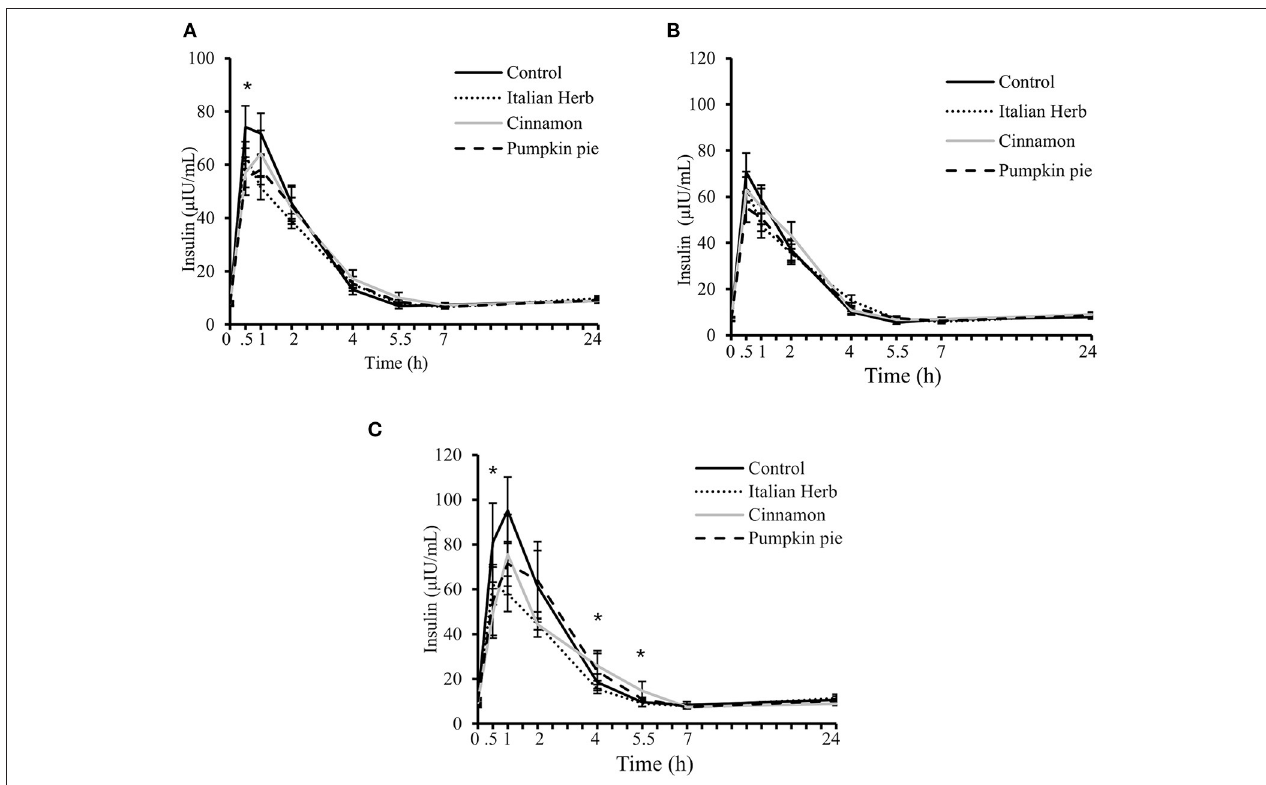
FIGURE 5 | Postprandial plasma insulin concentrations over 7h after consuming high-fat and high-carbohydrate (HFHC) challenge test meals with and without addition herbs and spices (H/S) followed by fasting 24-h plasma insulin concentration in (A) All evaluable subjects ( n = 23); (B) subjects with age < 40 years ( n = 15); (C) subjects with age ≥ 40 years ( n = 8). Main effect of meal ( P = 0.12), time ( P < 0.0001), meal by time interaction ( P = 0.04), and meal by time by age interaction ( P = 0.001). Data are means ± standard error of mean. Data were log-transformed prior to statistical analysis. PROC MIXED (SAS Institute, Inc., Cary, North Carolina) was used for repeated measures. *Significant meal effect at the time point, P <